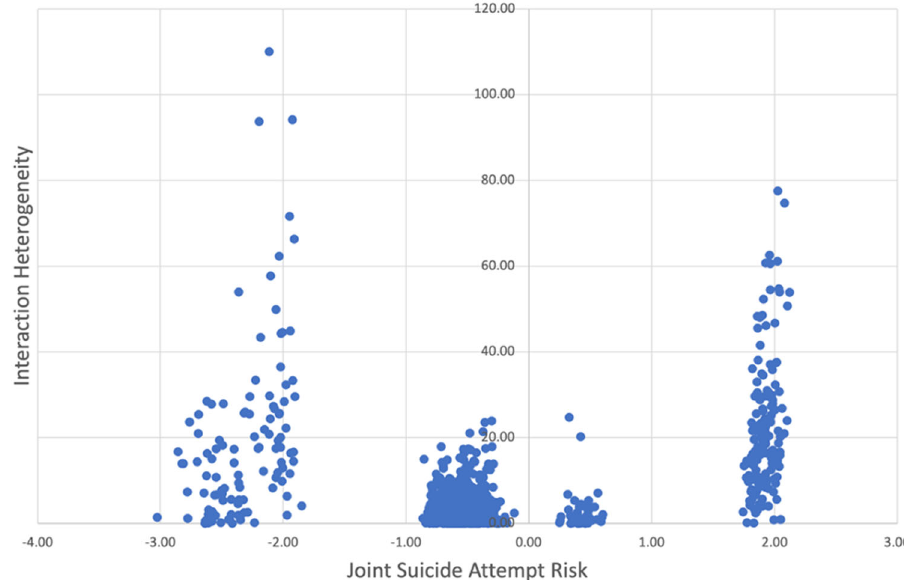
Fig. 5 Interaction heterogeneity versus joint suicide risk. A comparison of joint suicide attempt risk and interaction heterogeneity. Each data point corresponds to a structured-unstructured feature pair AB . The x -axis shows the joint suicide risk of features A and B , de fi ned as the log of the ratio of the expected joint occurrences of AB in the case vs. non case cohorts. The y -axis shows the interaction heterogeneity, a measure of how much the interaction between A and B differs between case and non-case cohorts. The plot shows that feature pairs with similar joint suicide attempt risk can have very different interaction heterogeneity.